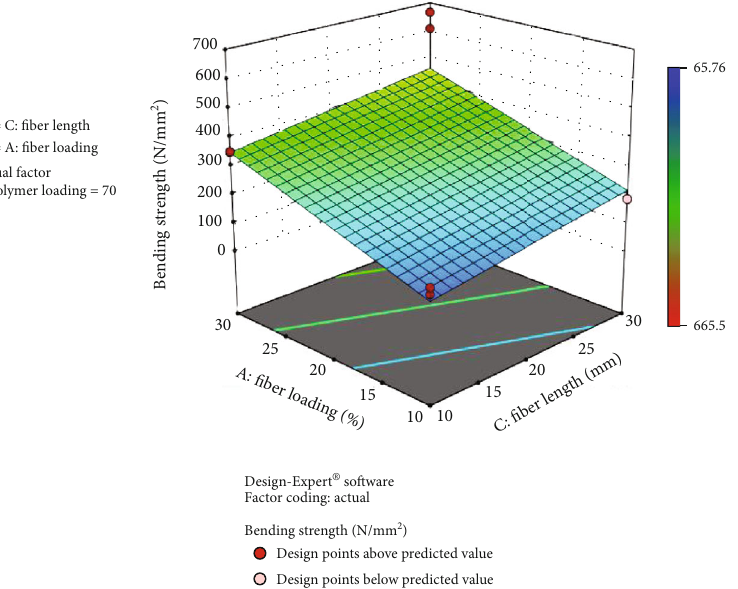
Figure 9: E ff ect of fi ber proportion as a function of fi ber length on fl exural